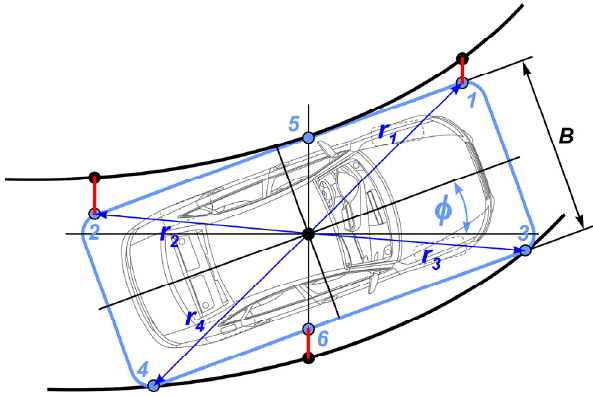
Figure 5. Scheme of the critical interactions with the motion boundaries.